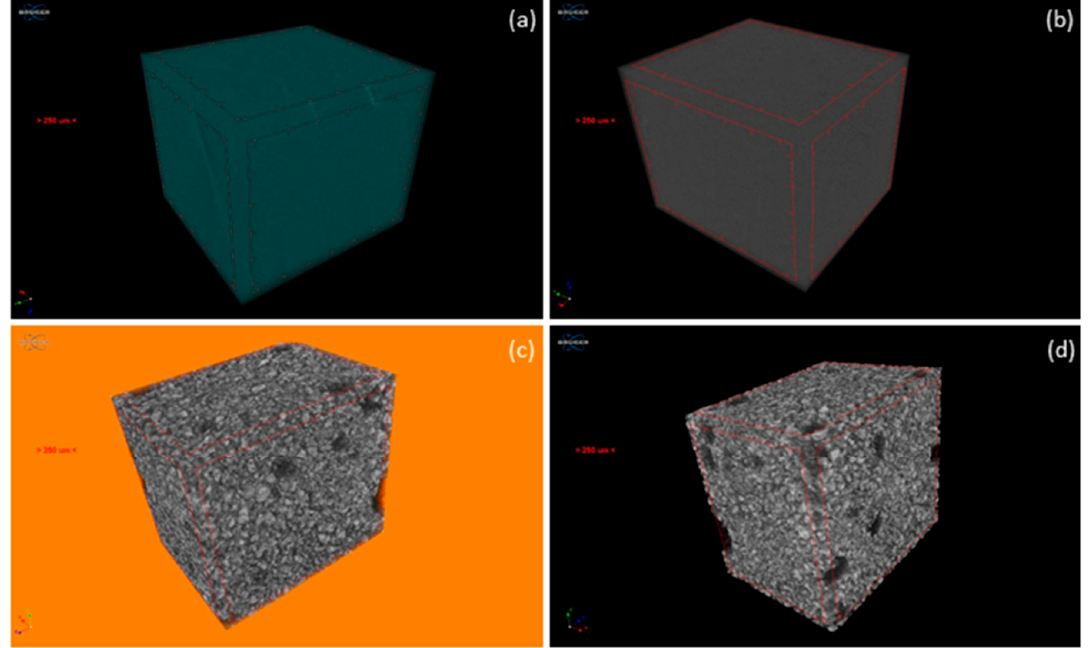
Figure 3. 3D internal image of the elastomer matrices ( a , b ) and the MRE composites ( c , d ) with isotropic filler distribution. 115